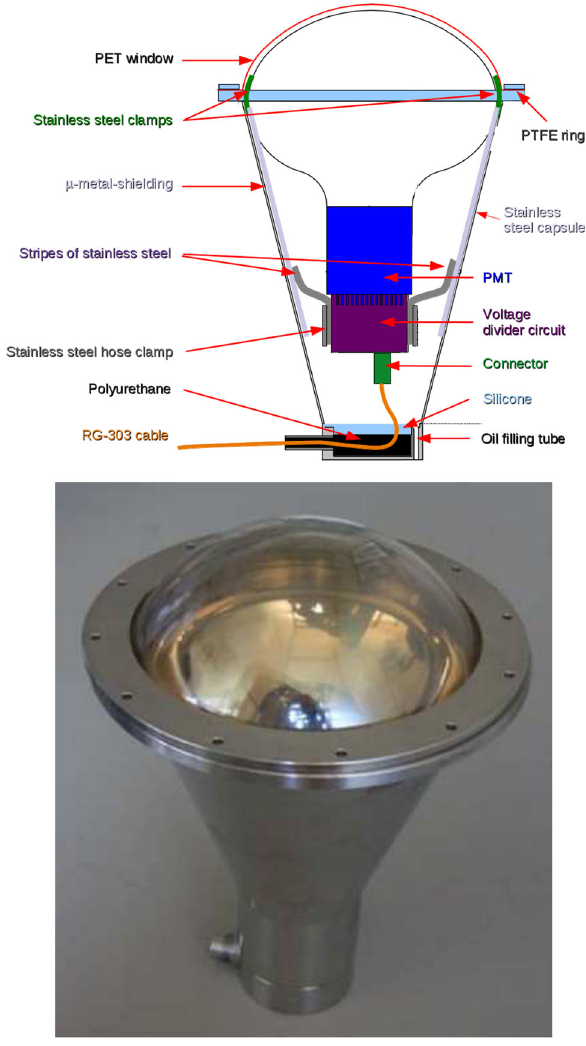
Fig. 17 Stainless steel enclosure with a transparent PET window, an oil-tight cable feedthrough, mu-metal shielding, the Hamamatsu R1408 PMT, and the PMT base. The inner volume was filled with mineral oil